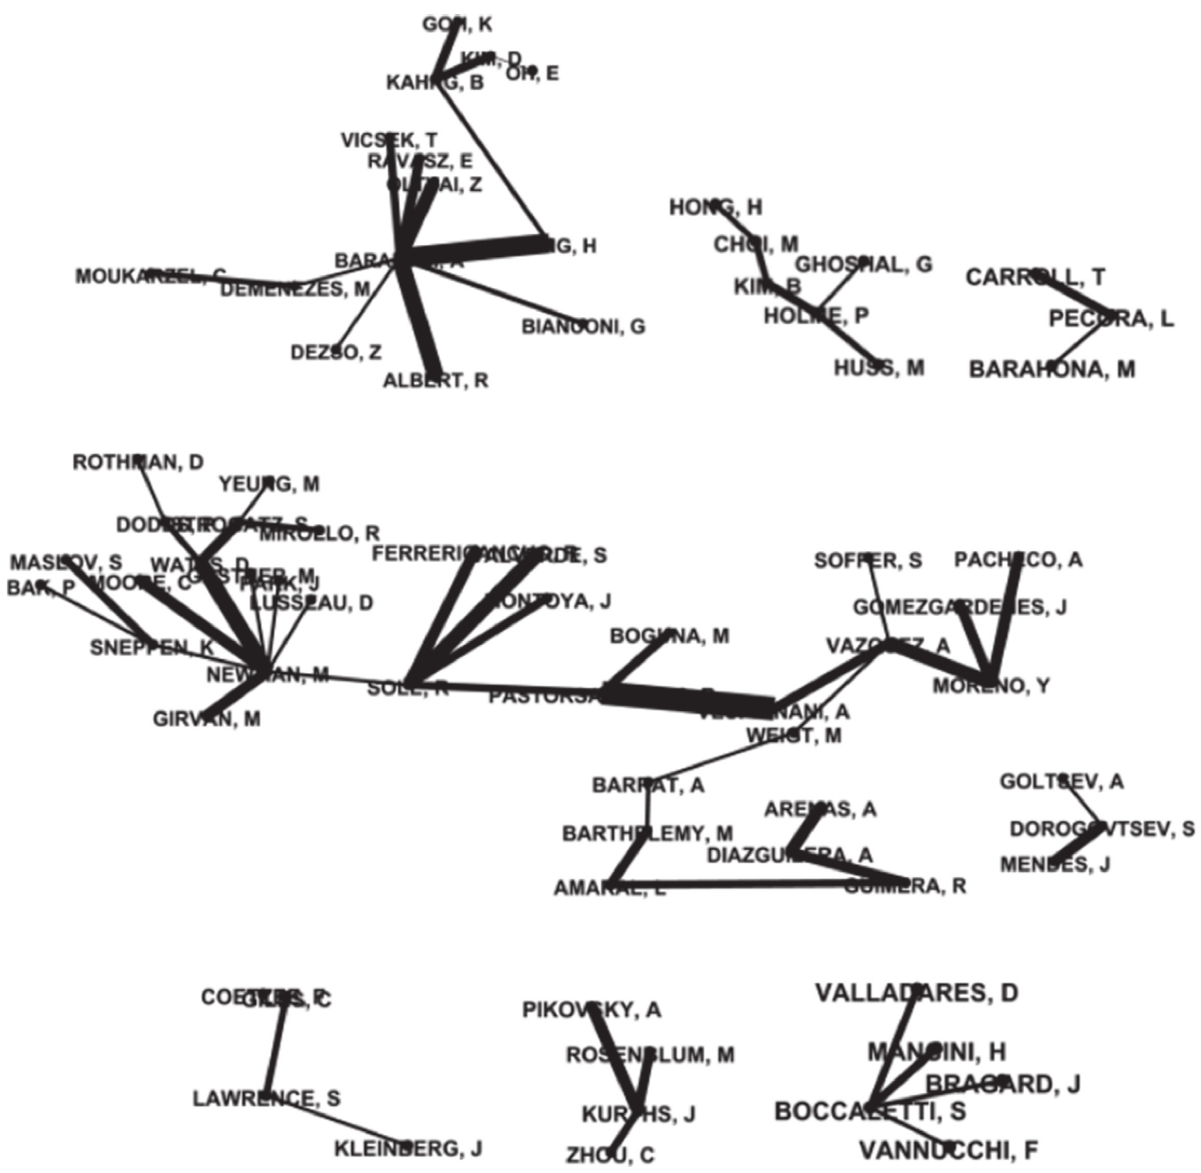
Figure 5: The maximum information transmission